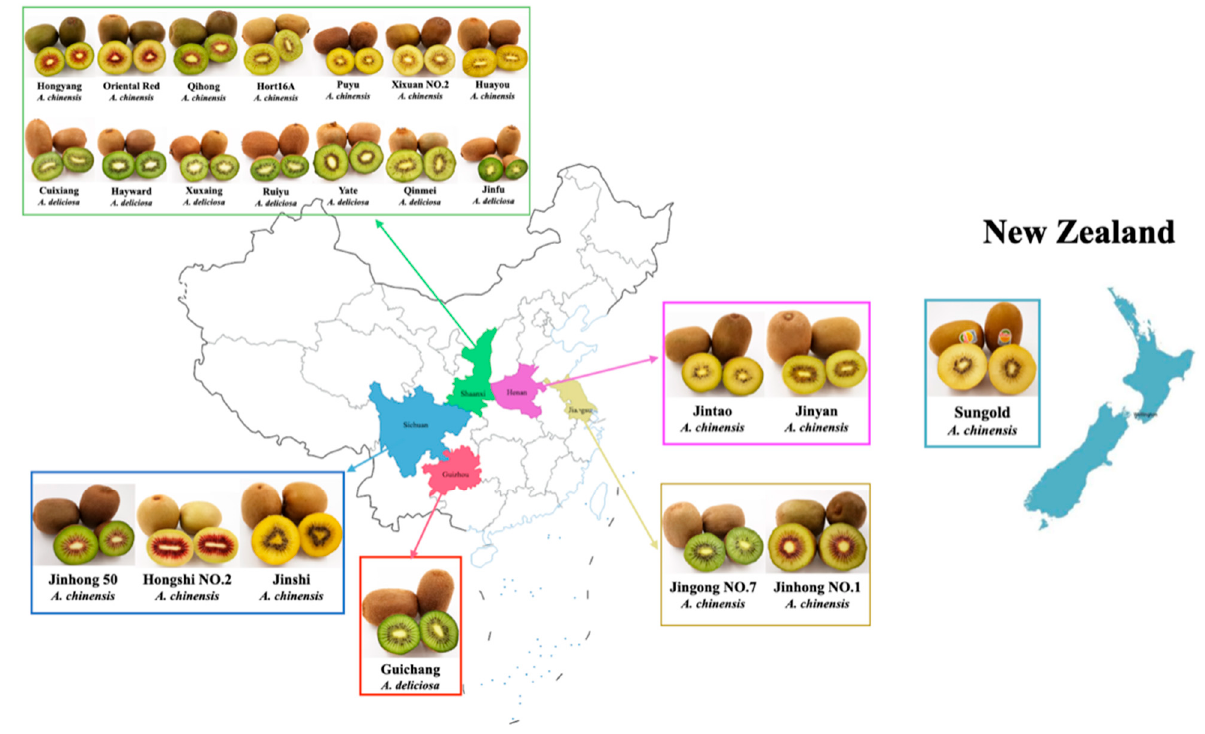
Figure 1. Origins, cultivars, flesh colors, and species of kiwifruit.